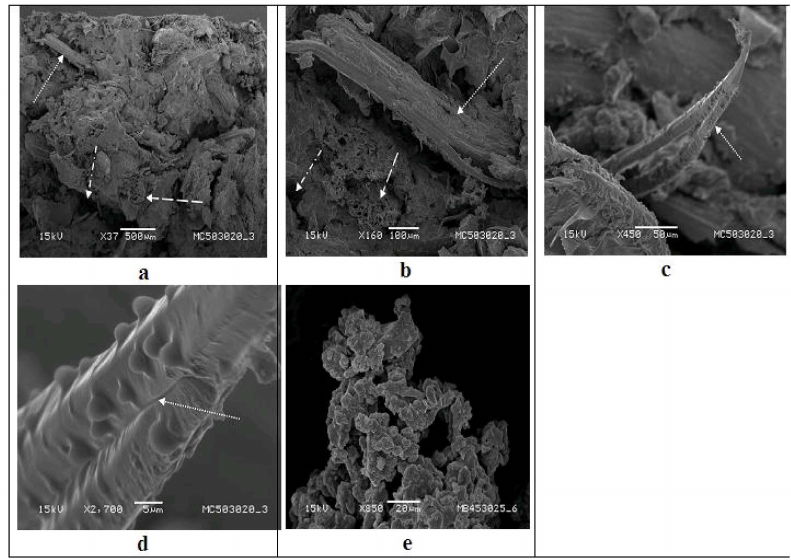
Figure 6. SEM photographs of castor oil cake—recovered glycerol (RG)—sugarcane bagasse fiber after the tensile test: ( a ) panoramic view of the fractured surface showing rough surface, fibers, cracks and voids; ( b ) region showing one fiber lying parallel and other embedded fractured fiber in the matrix; ( c , d ) pulled-out fiber covered with plasticizer (at two magnifications); ( e ) non-structured starch showing small polymorph granules.